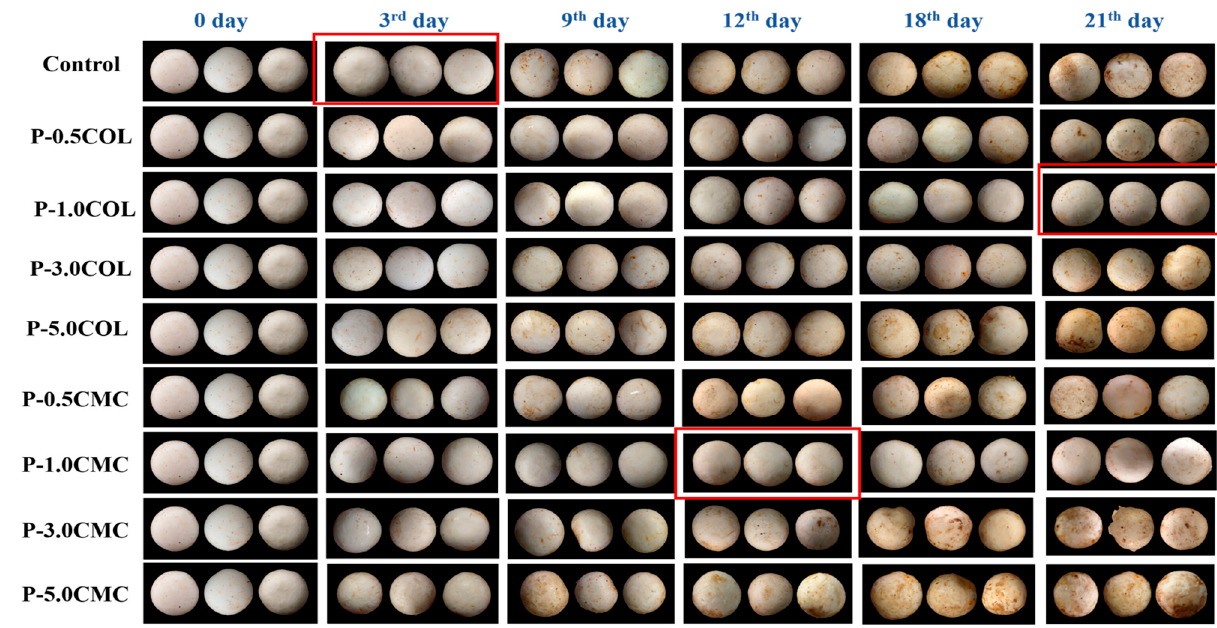
Figure 3. Appearance of A. bisporus after different packages stored at 4 °C for 21 days.